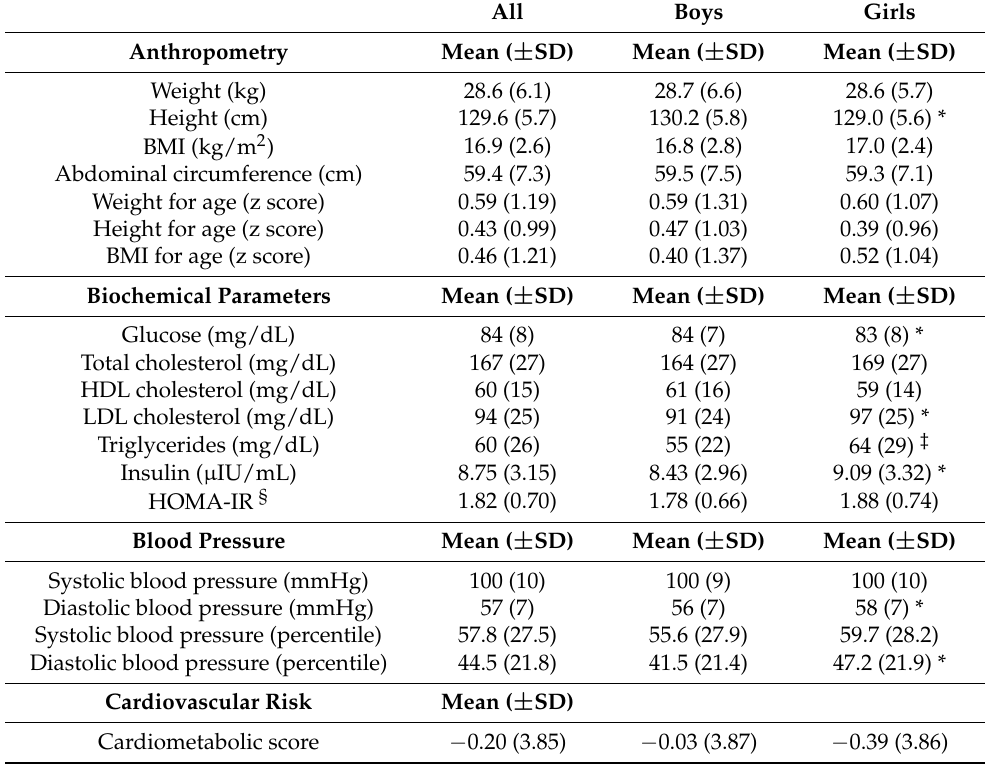
Table 3. Cardiovascular health-related parameters at age 8